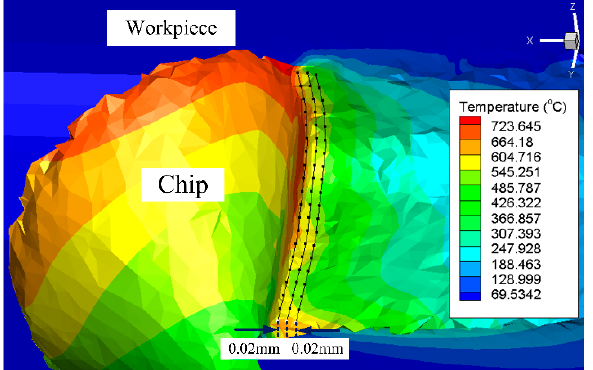
Figure 12. Measuring cutting temperature.